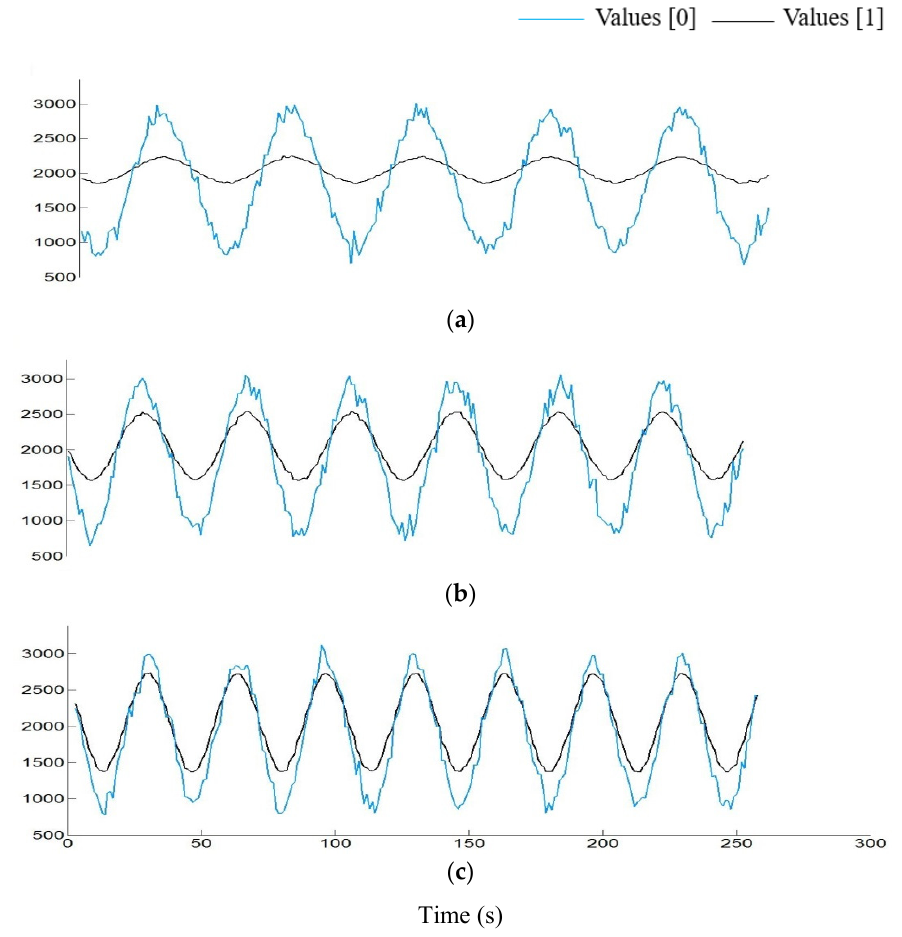
Figure 7. Received signals from motor phase terminal voltages and currents.